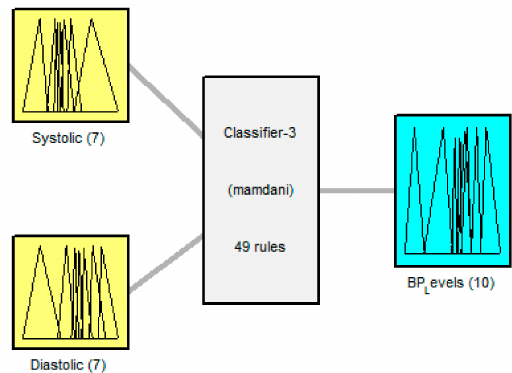
Figure 11. Structure of the fuzzy logic classifier 3.